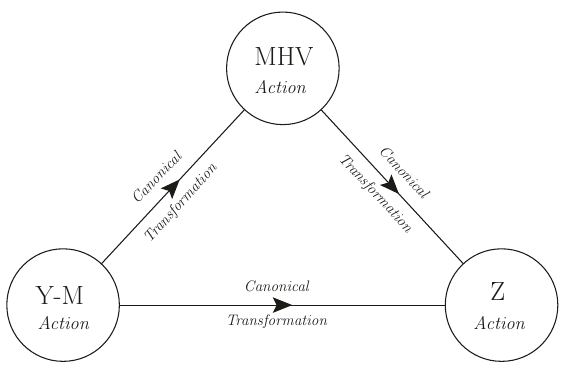
Figure 1 . Two ways to derive the new action. First is the direct method which involves the generating functional (2.7). Second involves two consecutive canonical field